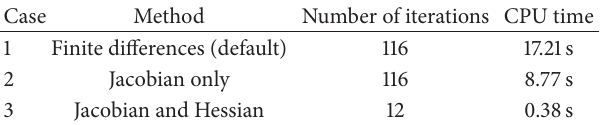
Table 3: Improvement with Jacobian and Hessian, 100